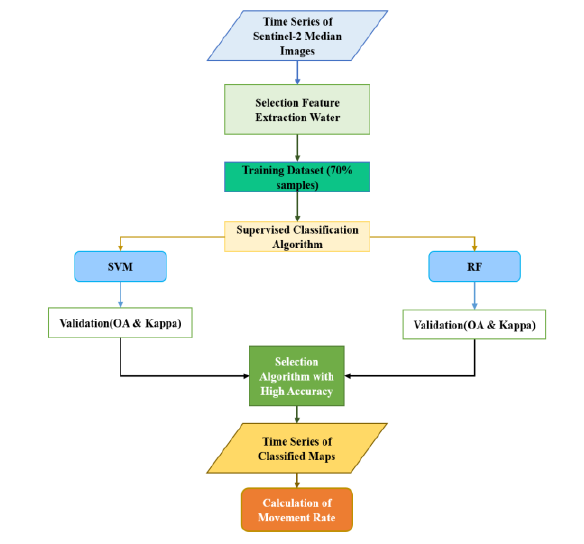
Figure 2. Flowchart of the methodology used for extraction of shorelines.